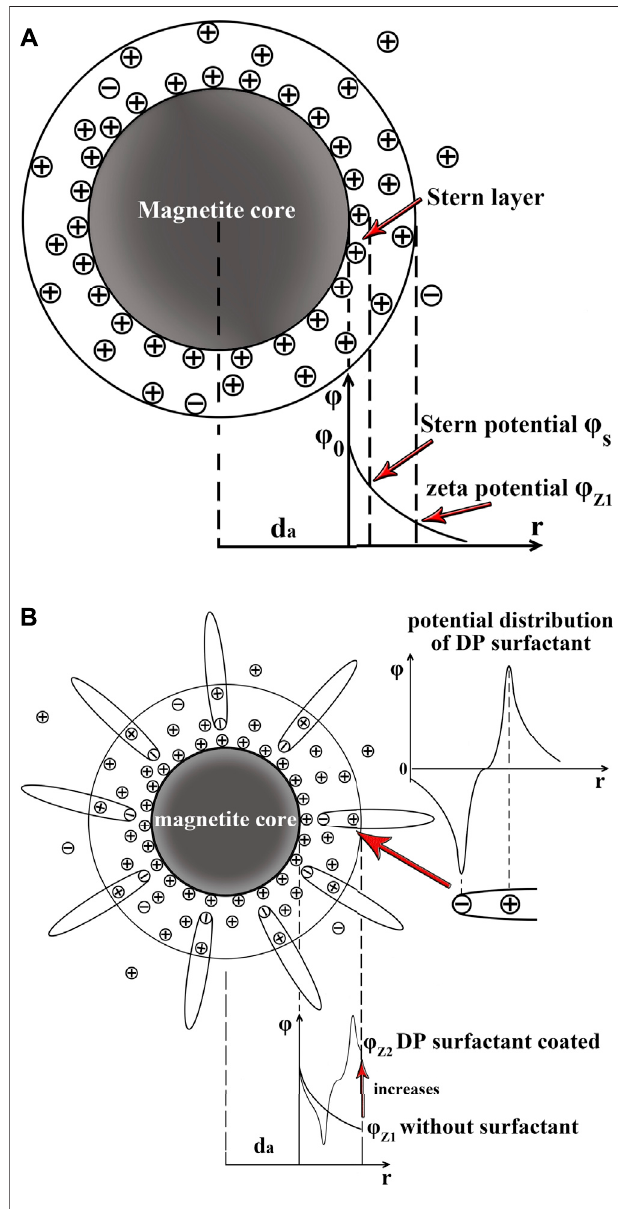
FIGURE 8 | (A) Electric double layer (EDL) and zeta potential ( φ z 1 ) of bare magnetite particles dispersed in polar carrier liquid. (B) Electric double layer (EDL) and zeta potential ( φ z 2 ) of DP-coated magnetite nanoparticles in polar-based